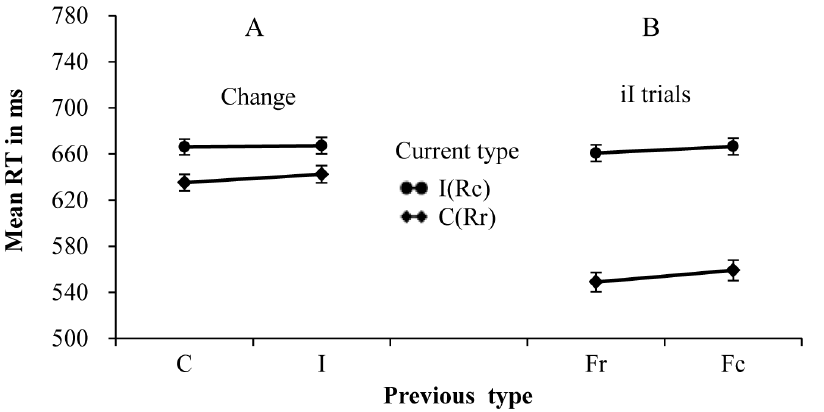
Figure 5. Mean RTs for each combination of current type and previous type. Panel A shows the results on change trials of all participants. Panel B shows the results on the iI trials of all participants. NB. I = incongruent trials, and C = congruent trials in panel A. Rc = response change, Rr = response repetition, Fr = flanker repetition, and Fc = flanker change in Panel B, respectively.